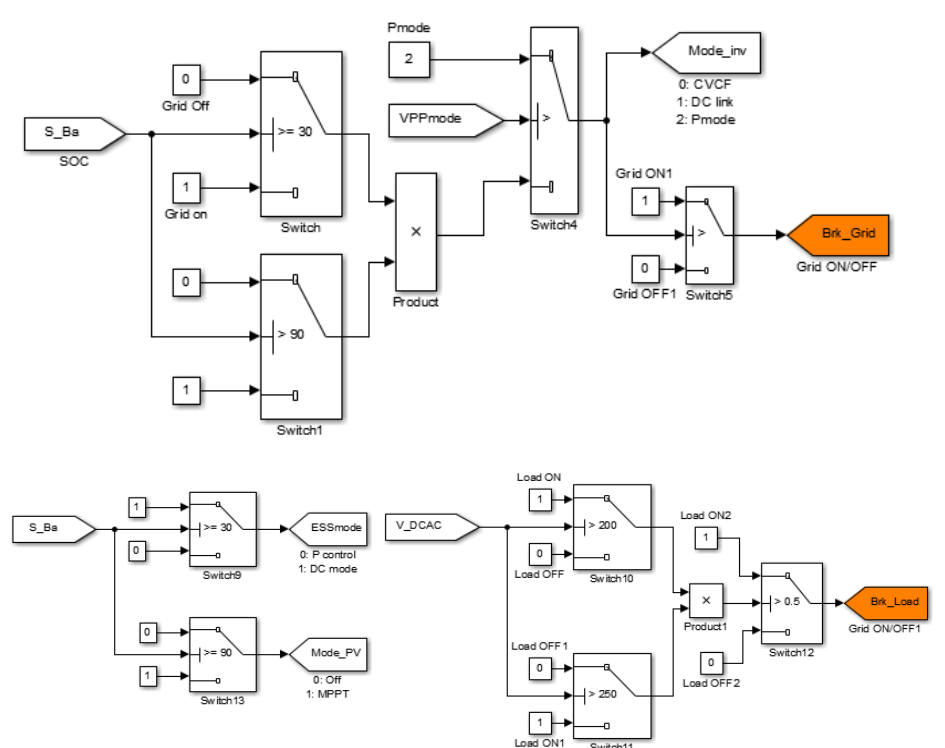
Figure A6. Block diagram of the VPP simulator.